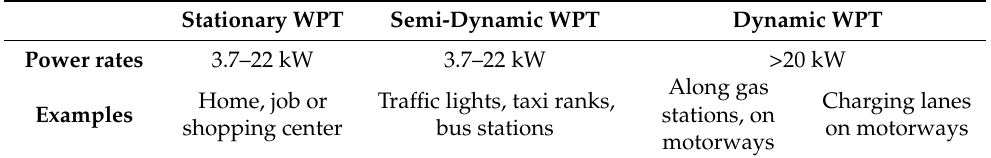
Table 1. Different WPT technologies for EVs [9]. Stationary WPT Semi-Dynamic WPT Dynamic WPT Power rates 3.7–22